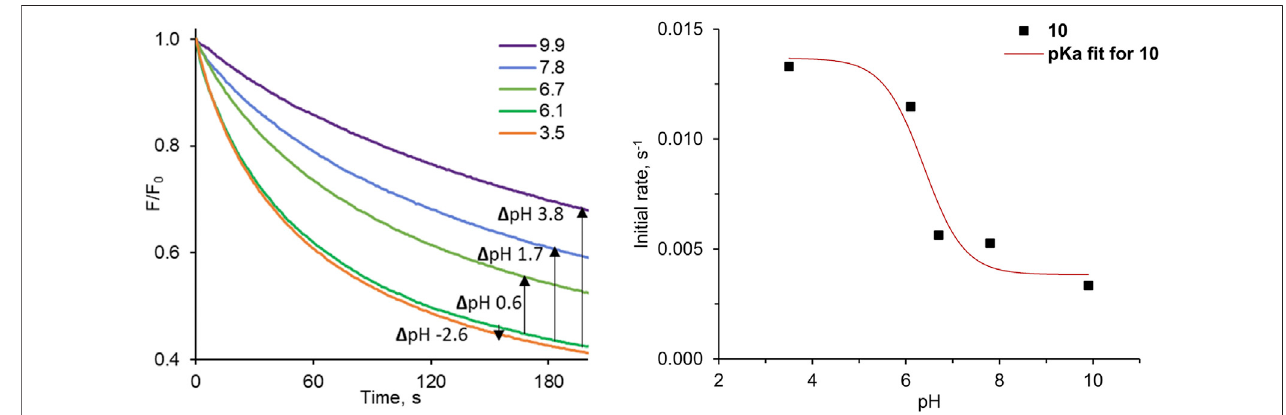
FIGURE 7 | Relative fl uorescence F/F 0 traces measured as a function of pH for the pH-dependent Cl − transport into 200 nm LUVs with pre-incorporated 10 at 1: 10,000 transporter:lipids